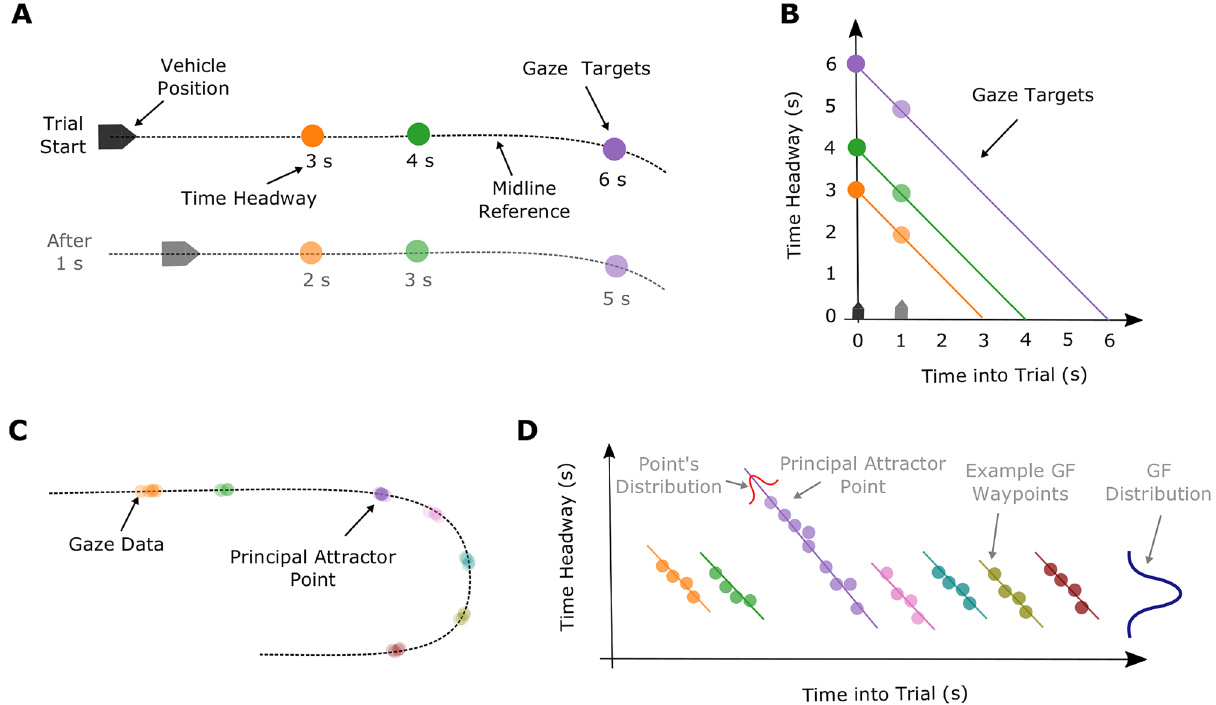
Figure 4. Gaze modelling. ( A ) Schematic top-down view of the waypoints along the midline reference (see Fig. 2) at two time points (0 s & 1 s into the trial). In ( B ) these two time points are plotted in the coordinate system of Time Headway of Gaze along the ordinate and Time into Trial along the abscissa. Each midline waypoint shown in A) represents a diagonal with a -1 slope in B ). ( C ) Idealised gaze data for a trial shown in spatial (top-down) coordinates. The principal attractor point (purple) is fixated earlier and for longer than other, routine, waypoints. ( D ) Idealised gaze data from ( C ) shown in Time Headway x Time into Trial coordinates. The routine Guiding Fixation (GF) waypoints have a similar mean time headway and duration of fixation, so can be approximated by a normal distribution. On the other hand, the principal attractor point is not captured by the GF normal distribution so needs its own regression